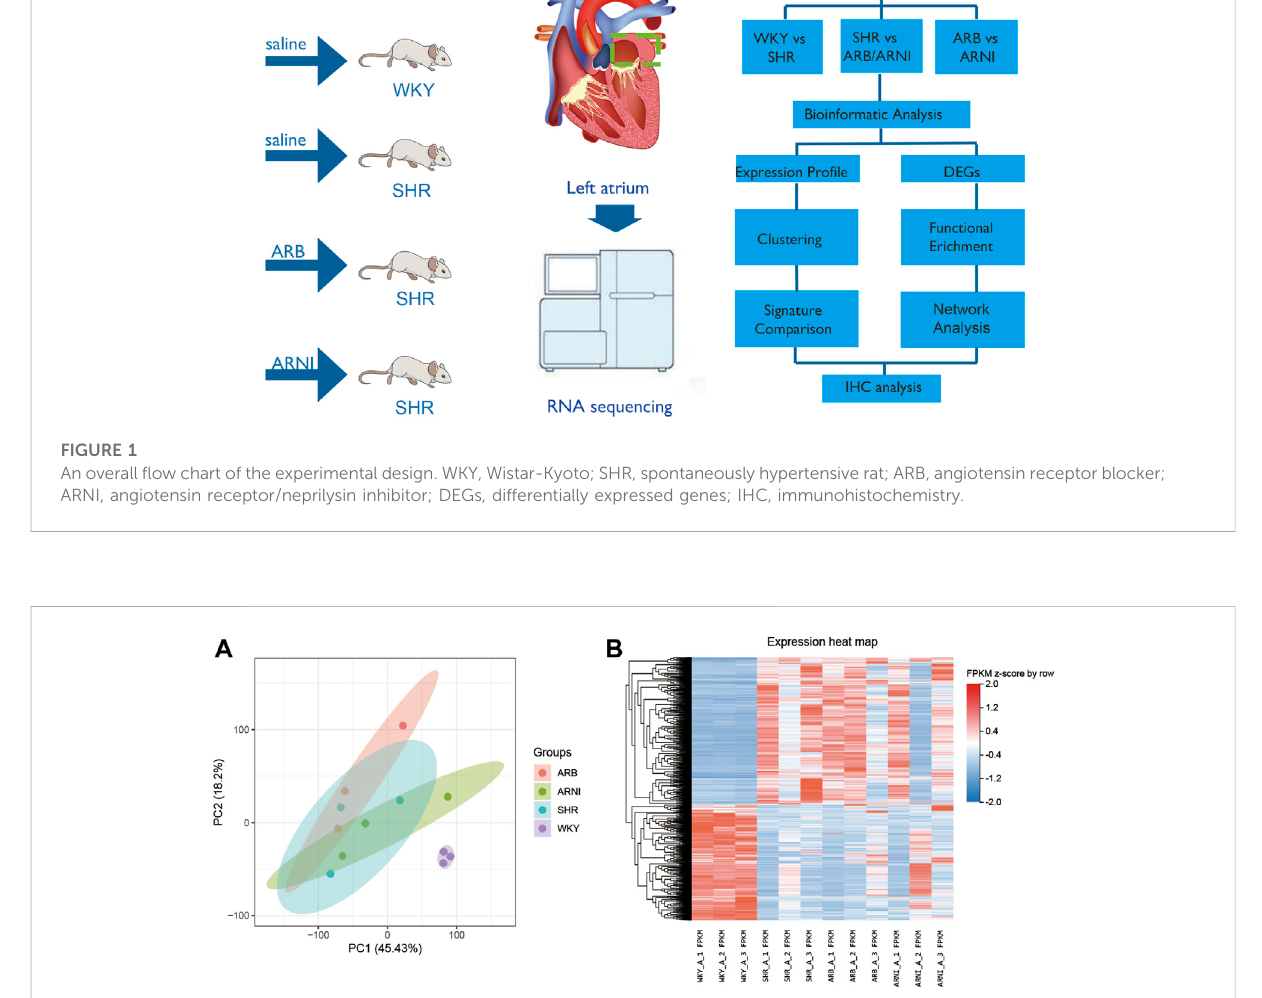
FIGURE 2 An overview of the transcriptomic landscape pro fi le in the rats ’ left atrium. (A) PCA analyse of transcriptome pro fi les between the four groups: the abscissa and ordinate represent different principal components and their contribution proportions. (B) Heatmap indicating the atlas of dysregulated genes in the four groups: the abscissa represents different groups of rats, the ordinate represents different genes, red represents up- regulated genes, and blue represents down-regulated genes. PCA, principal component analysis; WKY, Wistar-Kyoto; SHR, spontaneously hypertensive rat; ARB, angiotensin receptor blocker; ARNI, angiotensin receptor/neprilysin inhibitor; FPKM, fragments per kilobase of exon per million reads